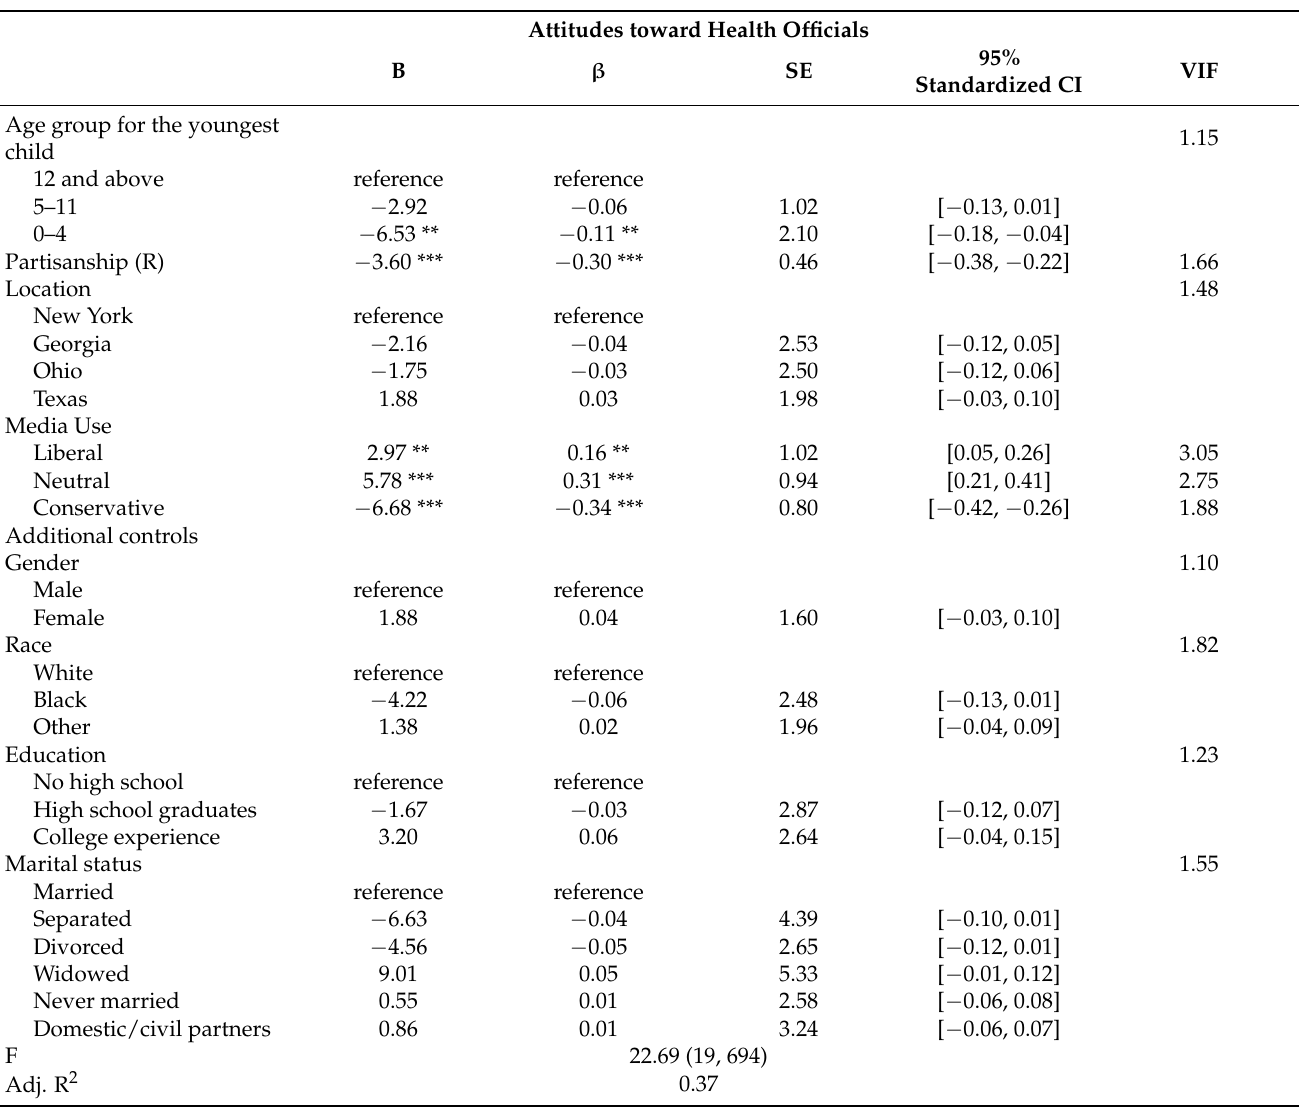
Table 2. Results for the OLS regression